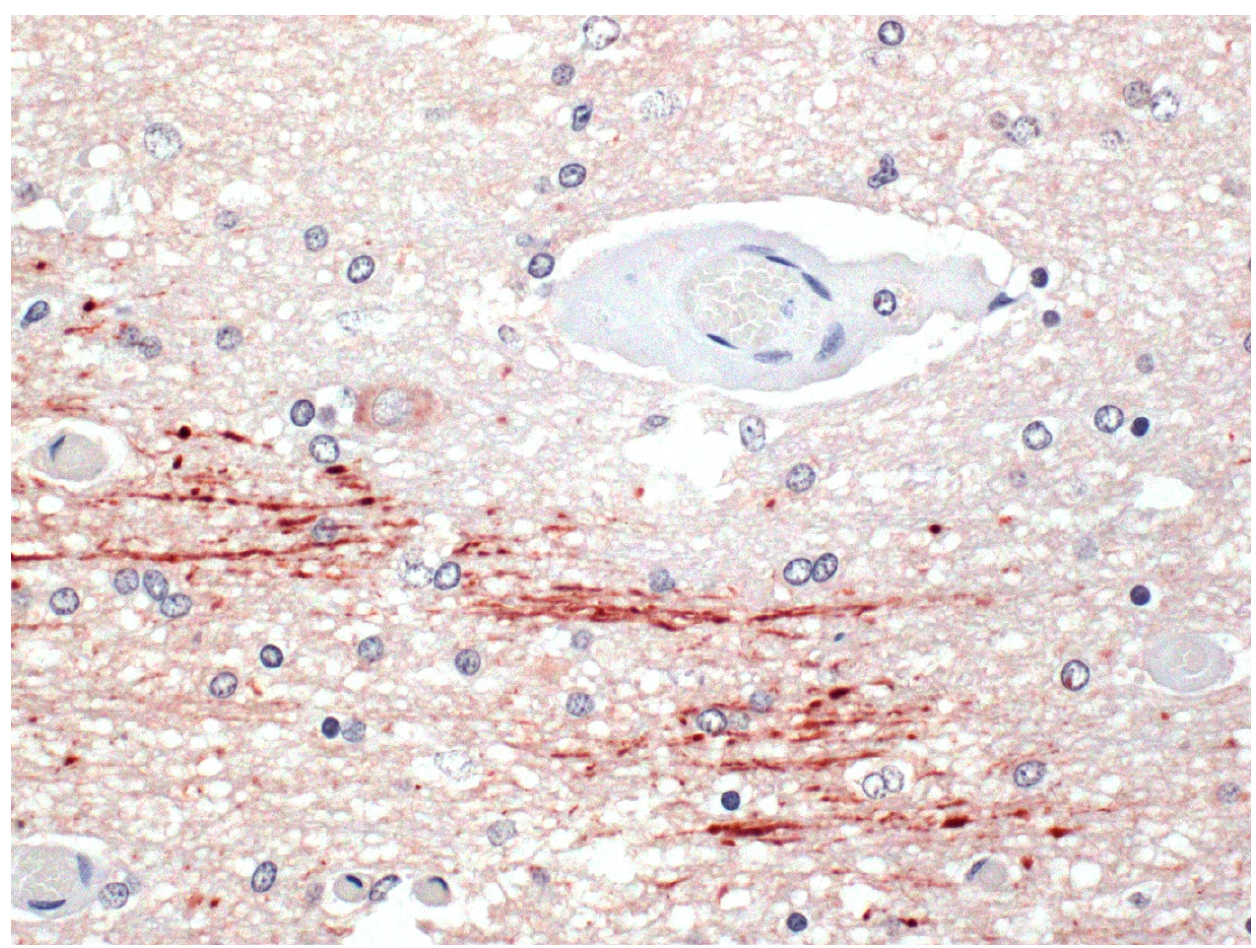
Figure 6. Focal symmetrical encephalomalacia. A focal necrotic area in the internal capsule showing abundant amyloid precursor protein (APP)-immunopositive inured axons in an area surrounding a blood vessel with perivascular edema. APP immunohistochemistry.